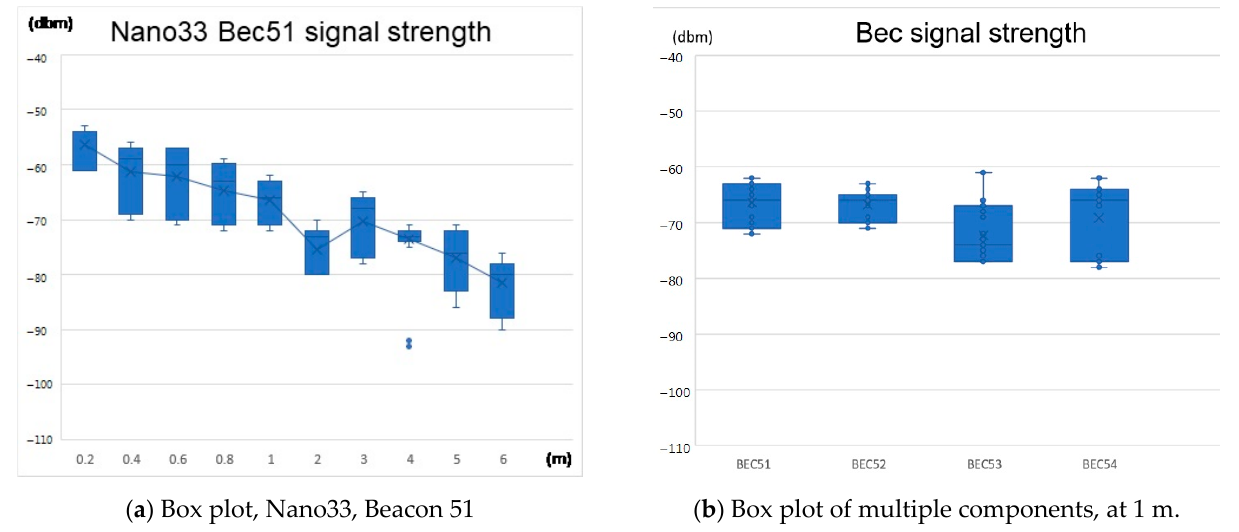
( b ) Box plot of multiple components, at 1 m. Figure 13. Signal strength box plots. Figure 13. Signal strength box